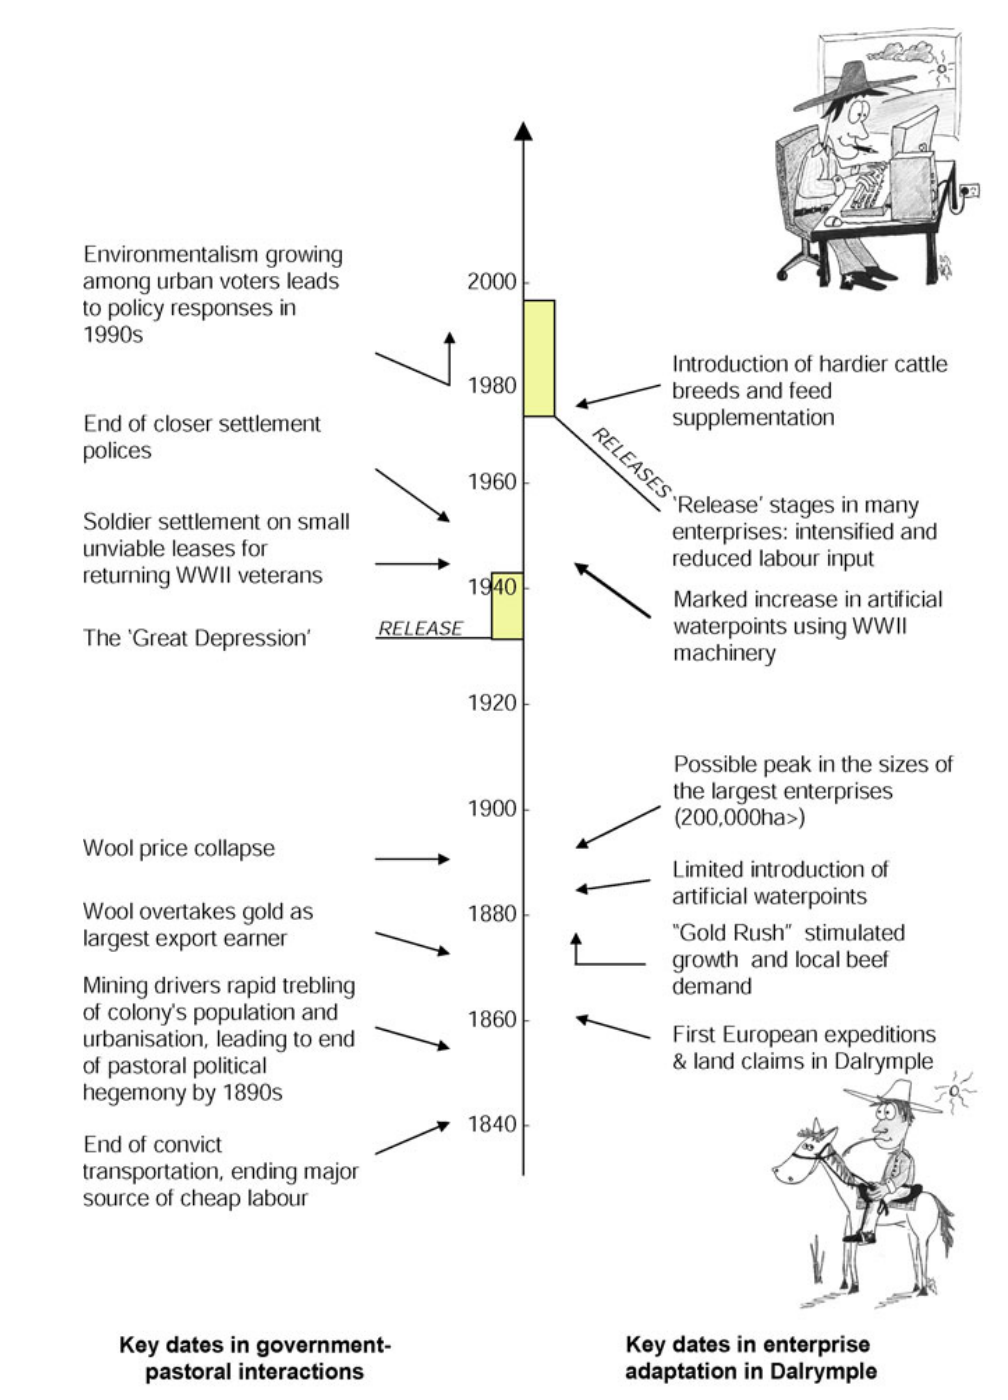
Fig. 3. Timeline, showing key events in government-pastoral interactions, and Dalrymple Shire pastoral- scale adaptations (original drawings by Brendan